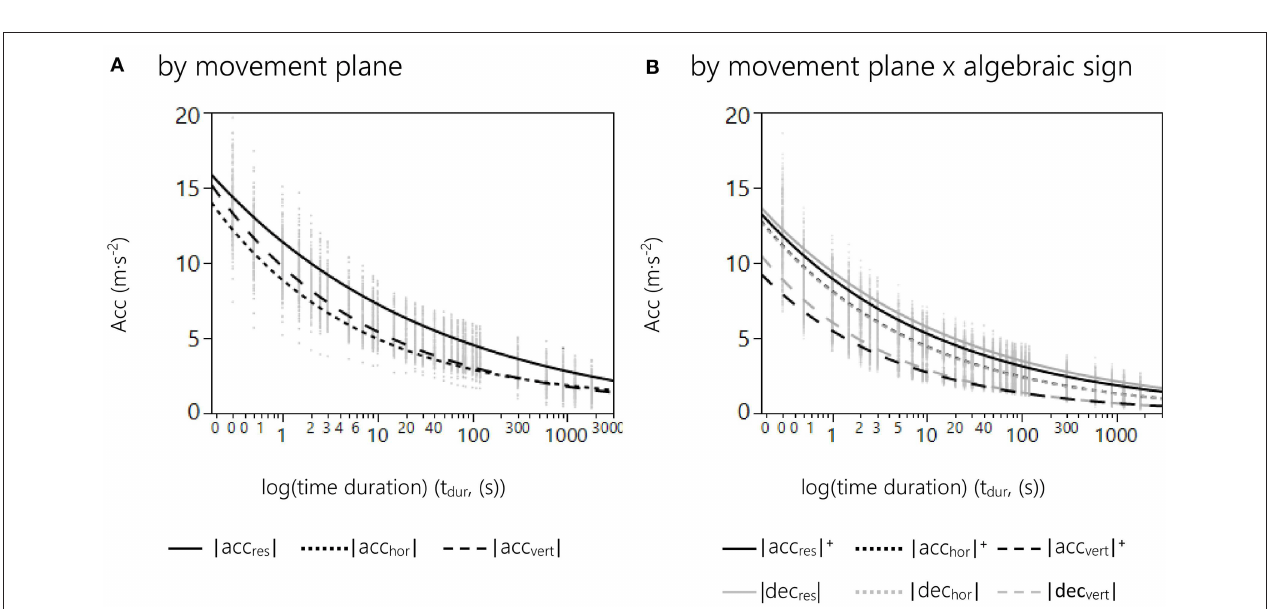
FIGURE 2 | (A) Curve fitting results of the 2 parameter exponential model grouped by movement plane. The graphs represent the relationship between peak median intensities over log-transformed time domains for |acc res | (solid), |acc hor | (dotted), and |acc vert | (dashed). Gray dots represent peak median accelerations for time durations from 0.3 to 1,800s for each game and player. (B) Curve fitting results of the 2 parameter exponential model grouped by movement plane The graphs represent the relationship between peak median intensities over log-transformed time domains for |acc res | + (black solid), |acc res | − (gray solid), |acc hor | + (black dotted), |acc hor | − (gray dotted), |acc vert | + (black dashed), and |acc vert | − (gray dashed). Gray dots represent peak median accelerations for the time durations from 0.3 to 1,800s for each game and player.